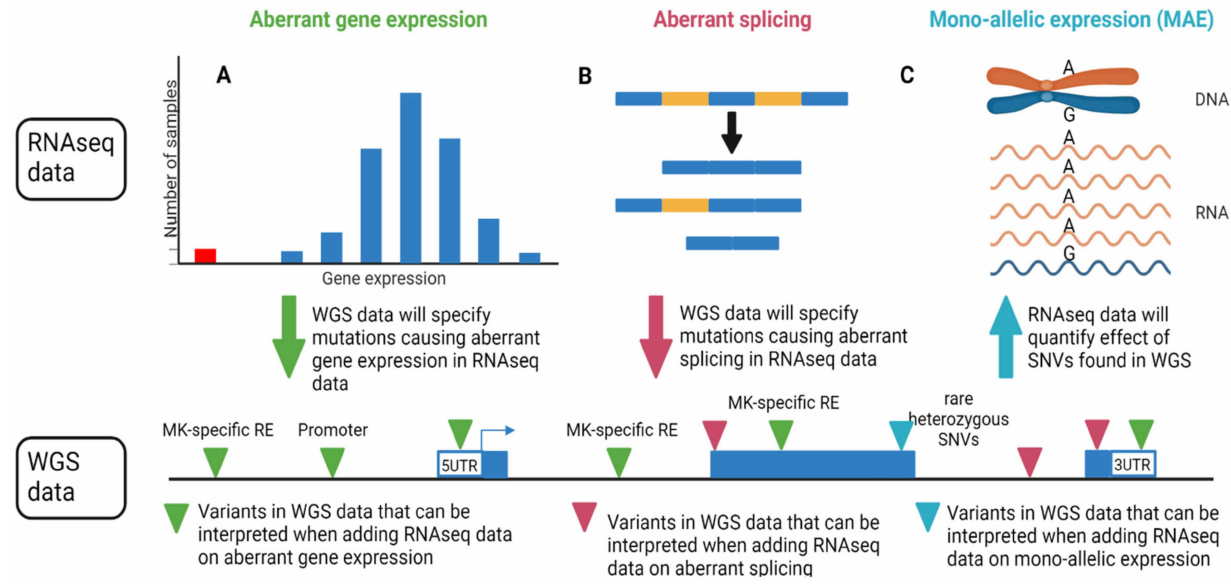
Figure 2. Schematic of information gained by combining RNA-seq data and Whole Genome Se- quencing (WGS) data. ( A ) RNA-seq gene expression outliers offer insight into the transcriptomic effect of coding and non-coding patient mutations in WGS data. ( B ) The probability of a change in DNA sequence causing alternative splicing can be predicted by deep learning. Predictions made for patient mutations seen in WGS data can be verified through splicing outlier detection in RNA-seq data. ( C ) The effect of heterogeneous patient mutations from WGS data is also dependent on monoal- lelic expression, in which one of the two alleles is (partially) unused. This can be quantified using RNA-seq